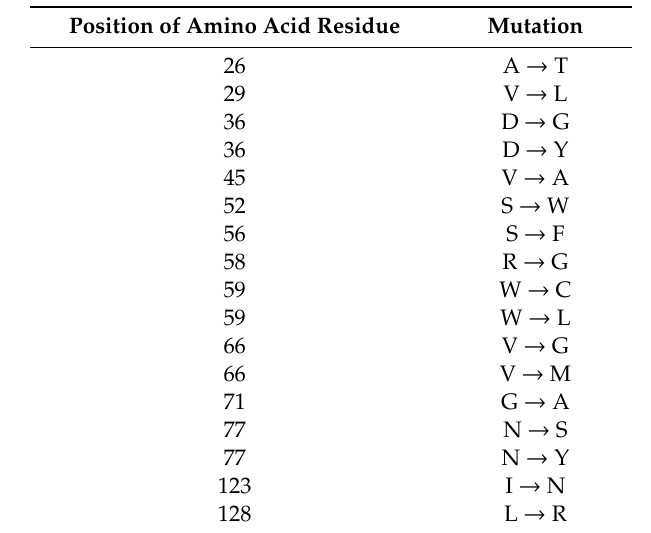
Table 1. Amino acid mutations in VKOR related to CMRES (based on https: // www.uniprot.org / uniprot / Q9BQB6) [31].